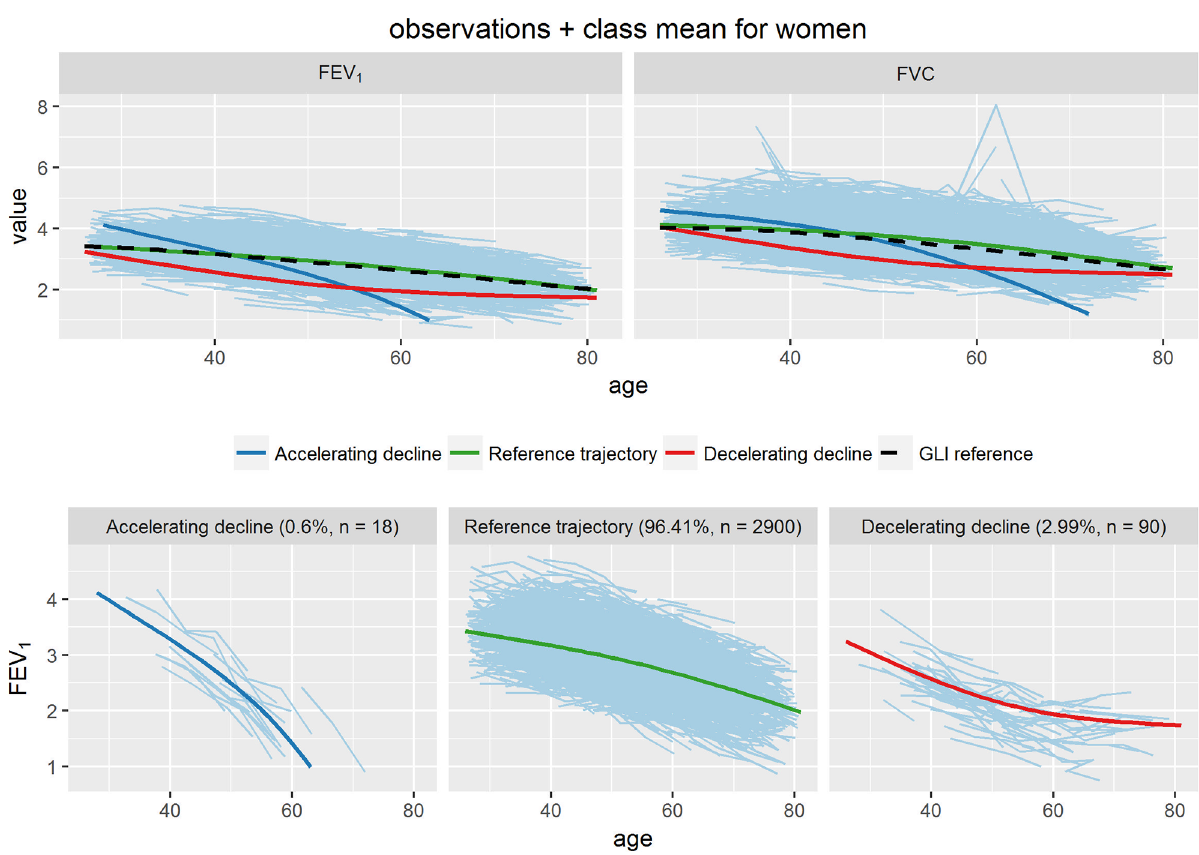
Fig 2. Trajectories of FEV 1 (Liters) for